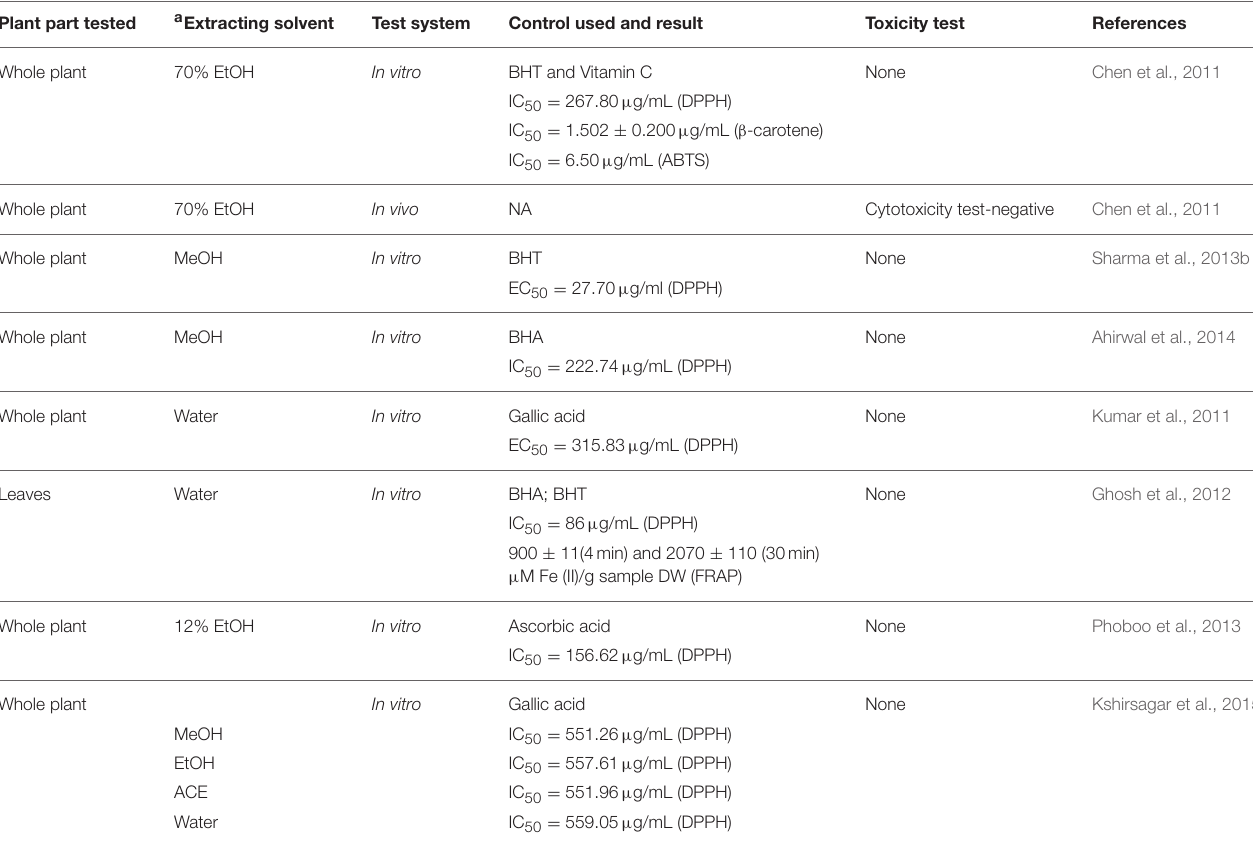
TABLE 3 | Antioxidant potential of different solvent extracts of S. chirayita Plant part